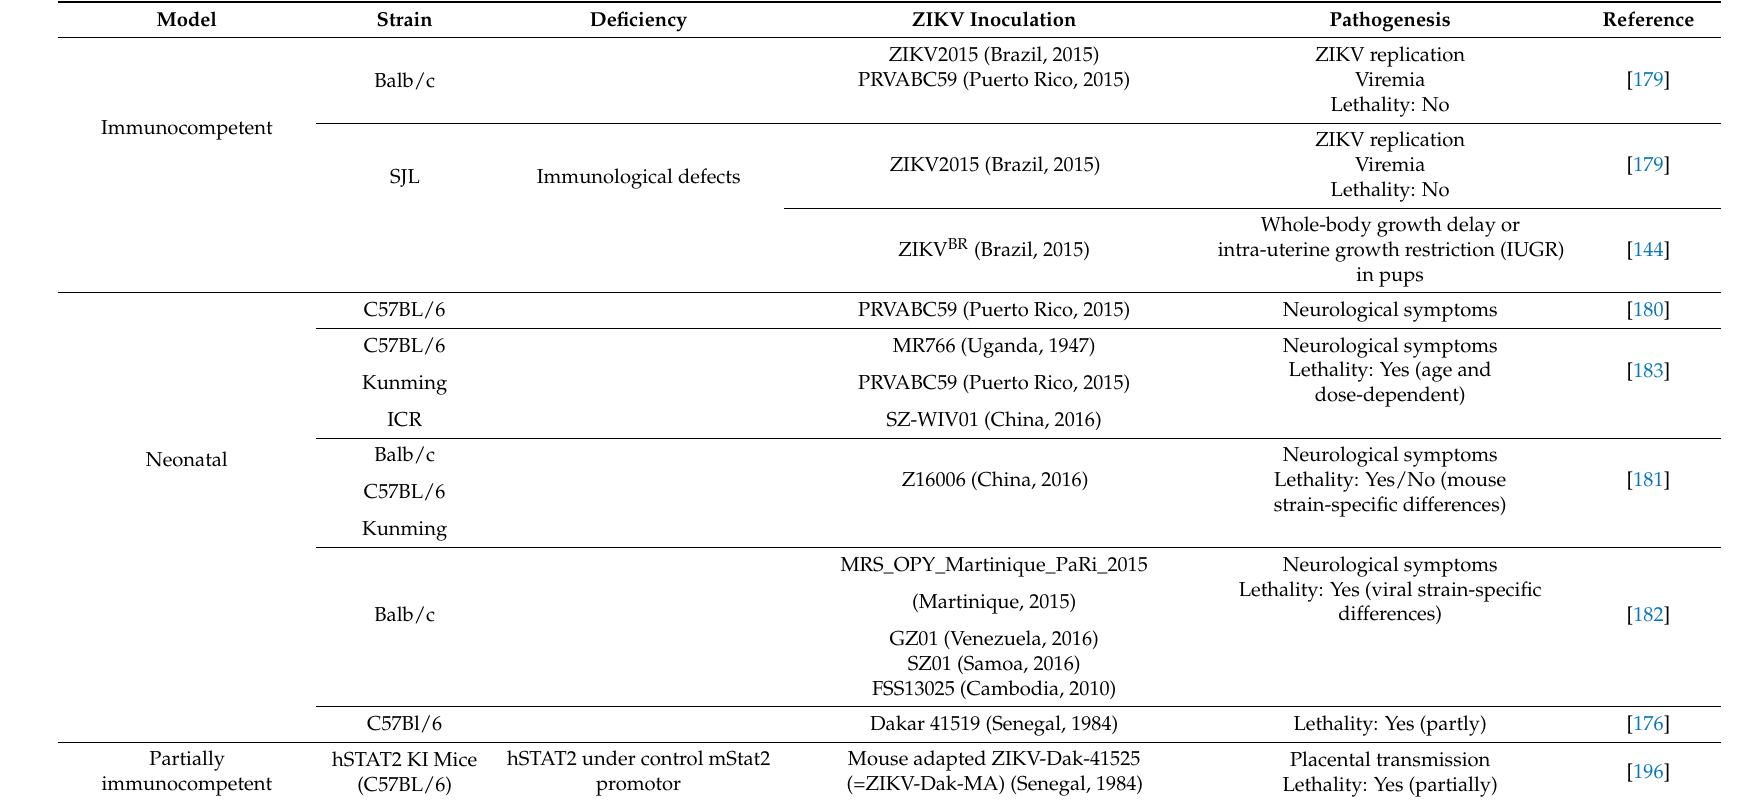
Table 3. Mouse models of ZIKV